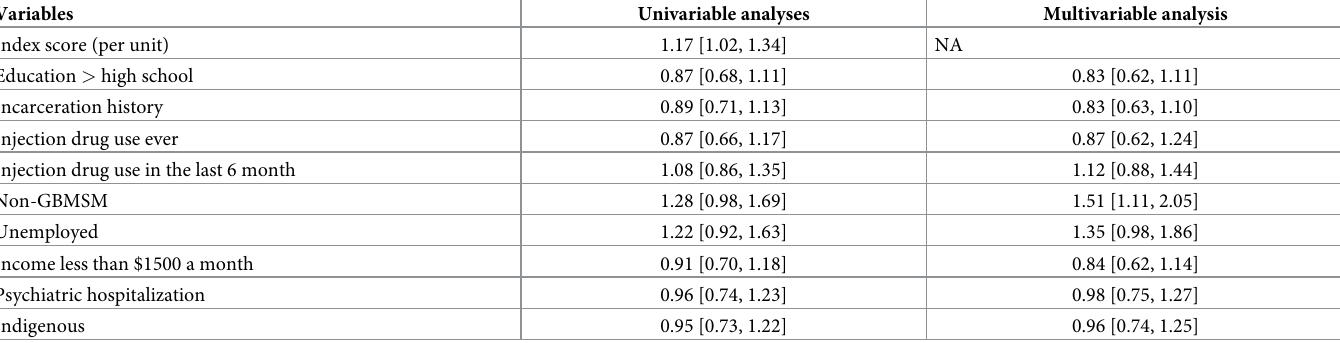
WAIC for the model with the index alone was 1900.7 whereas the WAIC for the multivariable model with all the indicators was 1907.5 indicating that the model using the index alone also had a better goodness of